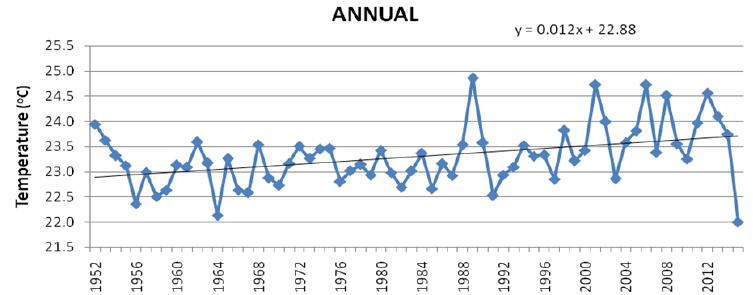
Figure 10. The time series of the annual maximum temperature.